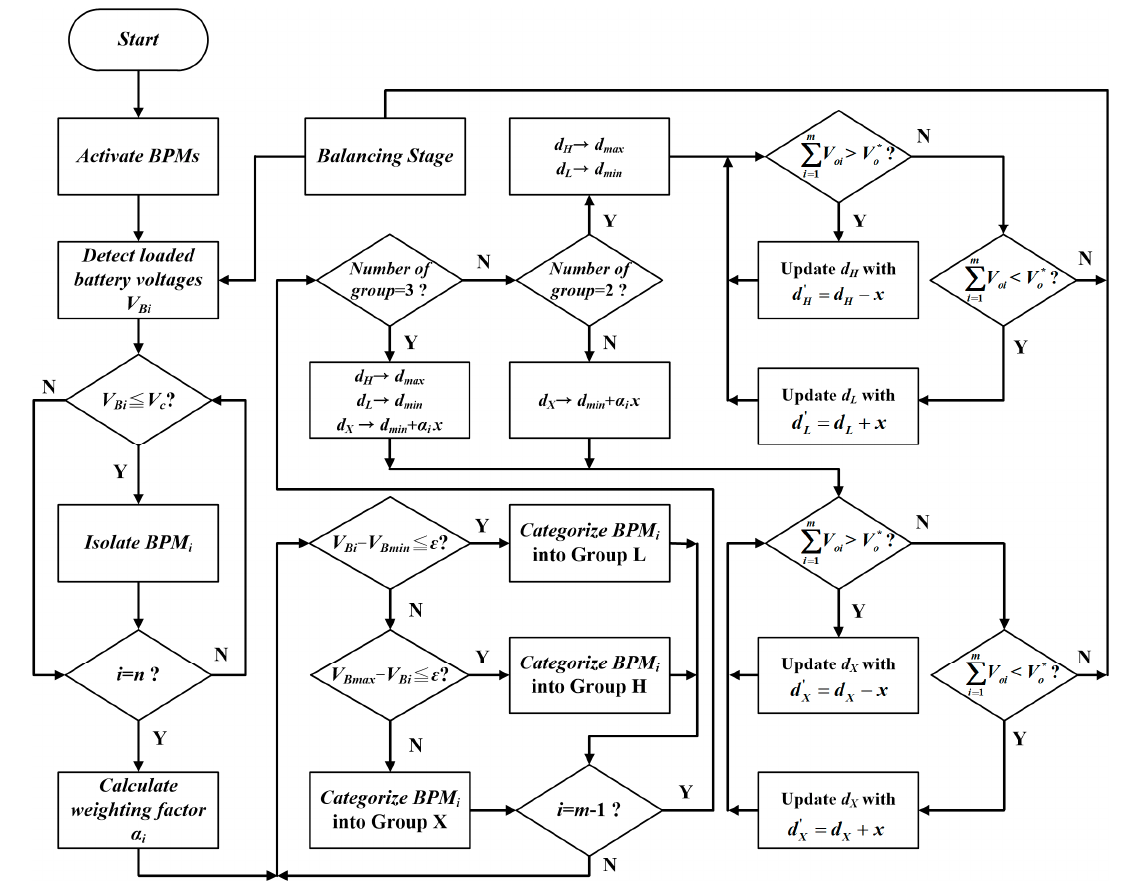
Figure 4. Control flowchart of the discharging scenario.